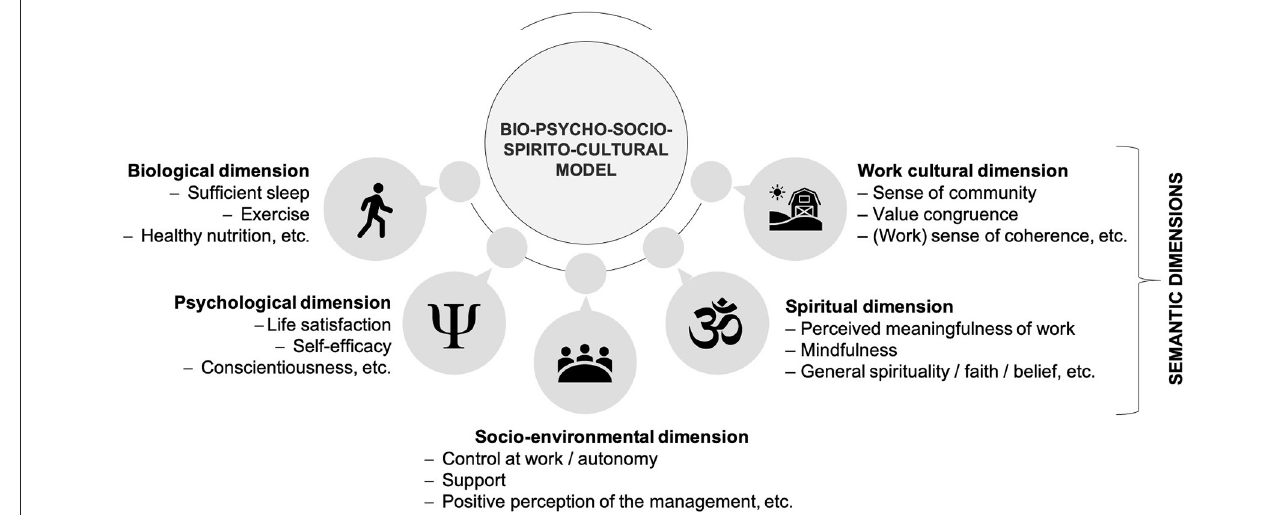
FIGURE 2 | The bio-psycho-socio-spirito-cultural model (extension of the existing